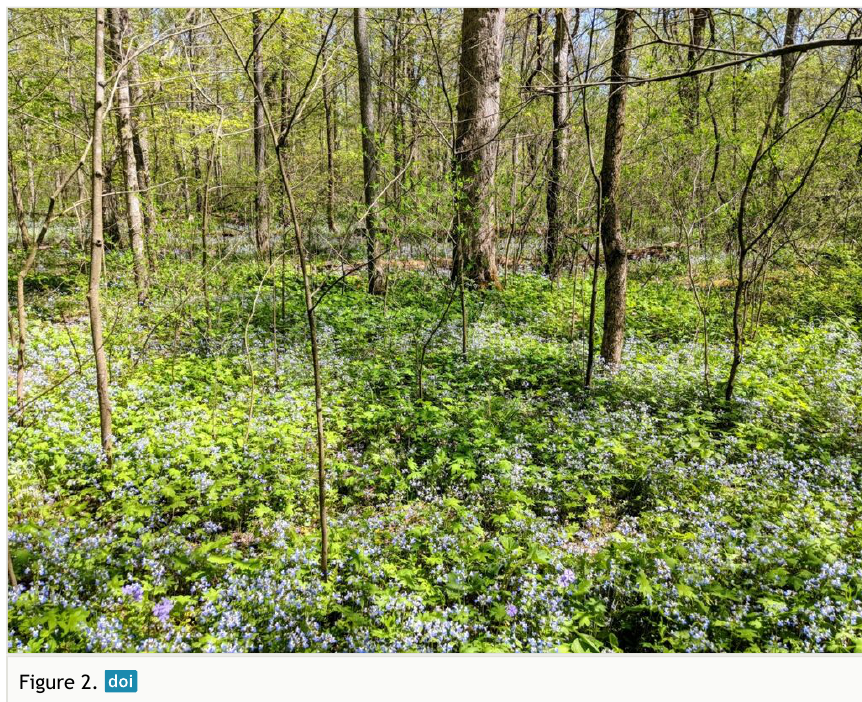
Rocky Bluff (Crab Orchard National Wildlife Refuge) in early spring, a typical forested habitat of Southern Illinois. Collinsia verna (Scrophulariaceae) in bloom. Photo credits